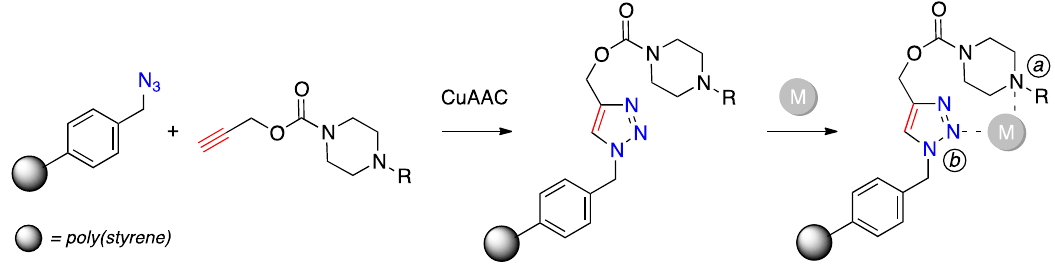
Figure 1. General scheme for the preparation of triazolic-piperazine polymers: Possible chelation methods as pendant ( a ), triazole ( b ) and integrated designs ( a , b ).